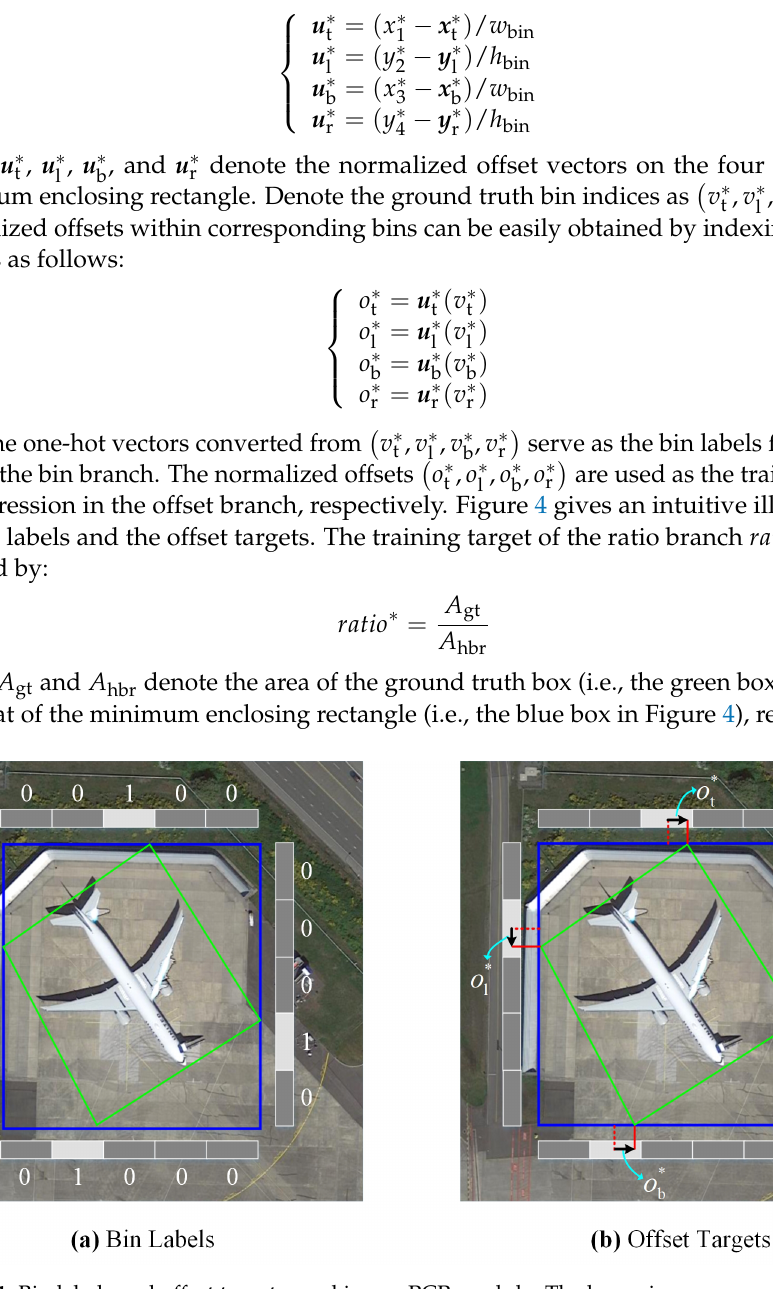
Figure 4. Bin labels and offset targets used in our PCR module. The boxes in green are ground truths and the boxes in blue are their minimum enclosing